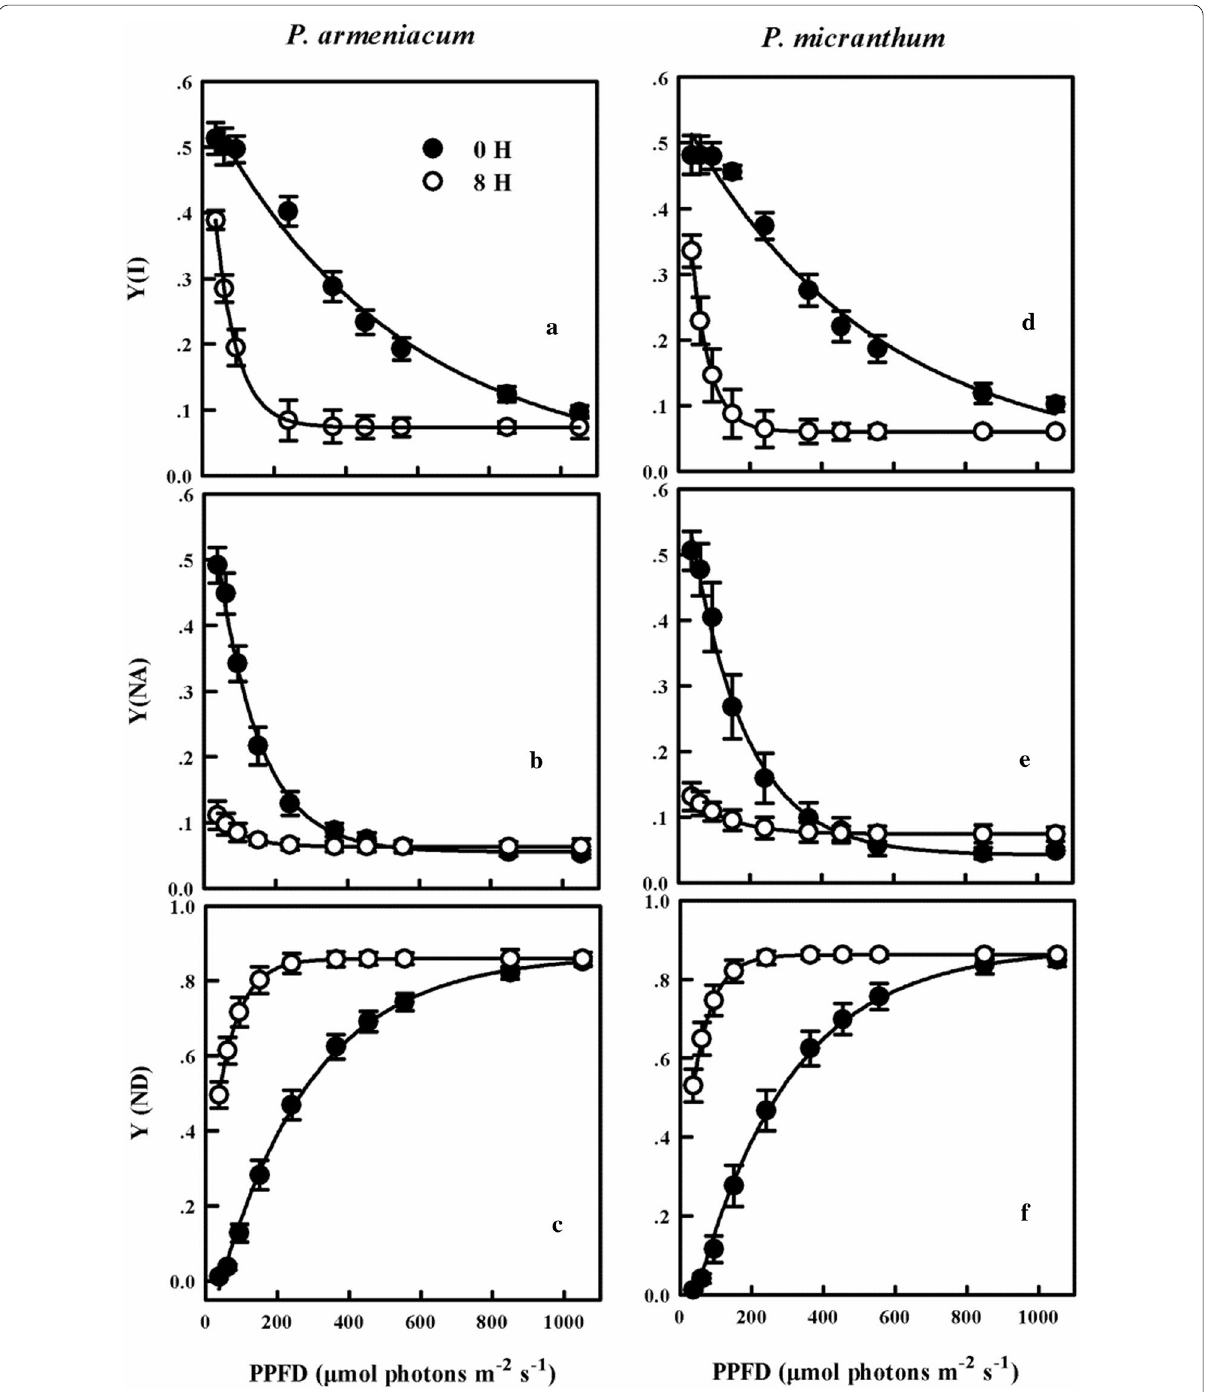
Fig. 7 Light response curves for Y(I) ( a , d ); Y(NA) ( b , e ) and Y(ND) ( c , f ) from three species of Paphiopedilum after 8 h chilling stress. Mean calculated from six independent plants per